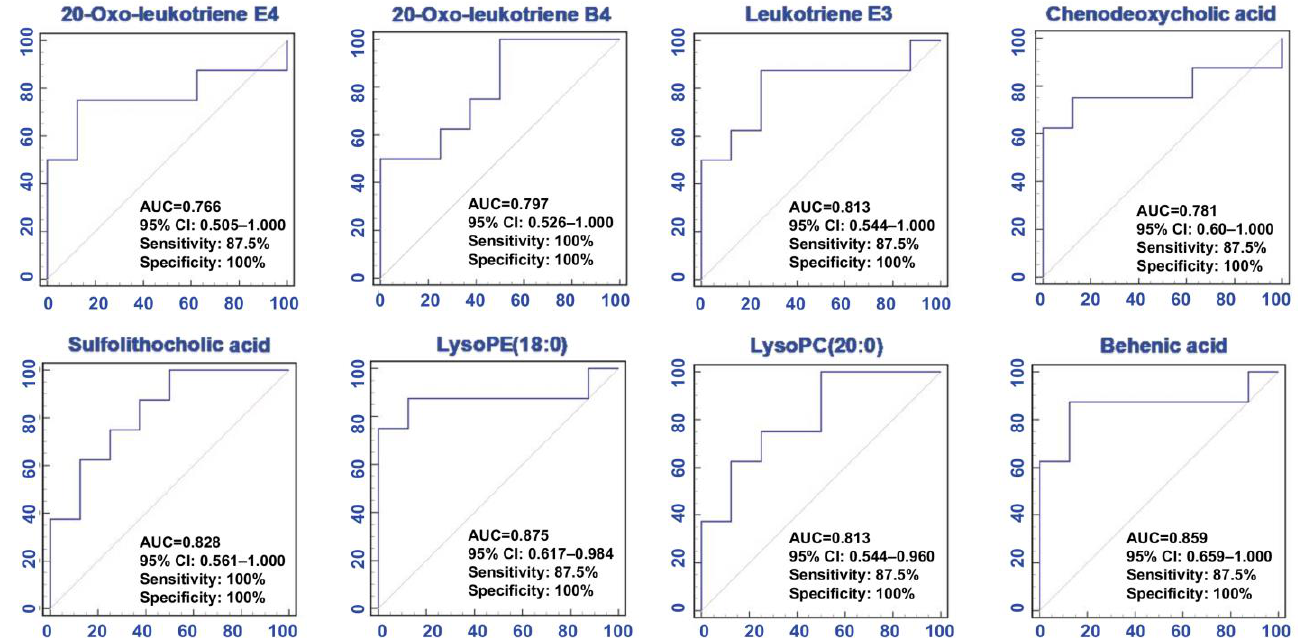
Figure 3. The levels of significantly altered lipid species linked with impaired kidney function in CRF. Eight lipid species were analyzed by using partial least square-discriminant analysis (PLS-DA)-based Receiver Operating Characteristic Curve (ROC) curves in CRF. The associated area under the curve (AUC), 95% confidence interval (CI), sensitivity, and specificity values were indicated.